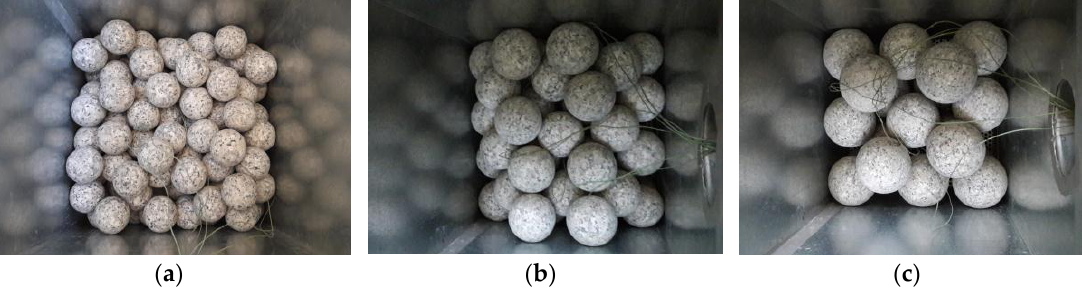
Figure 6. Spheres of ( a ) 50 mm, ( b ) 70 mm, and ( c ) 90 mm in diameter arranged in the packed bed.